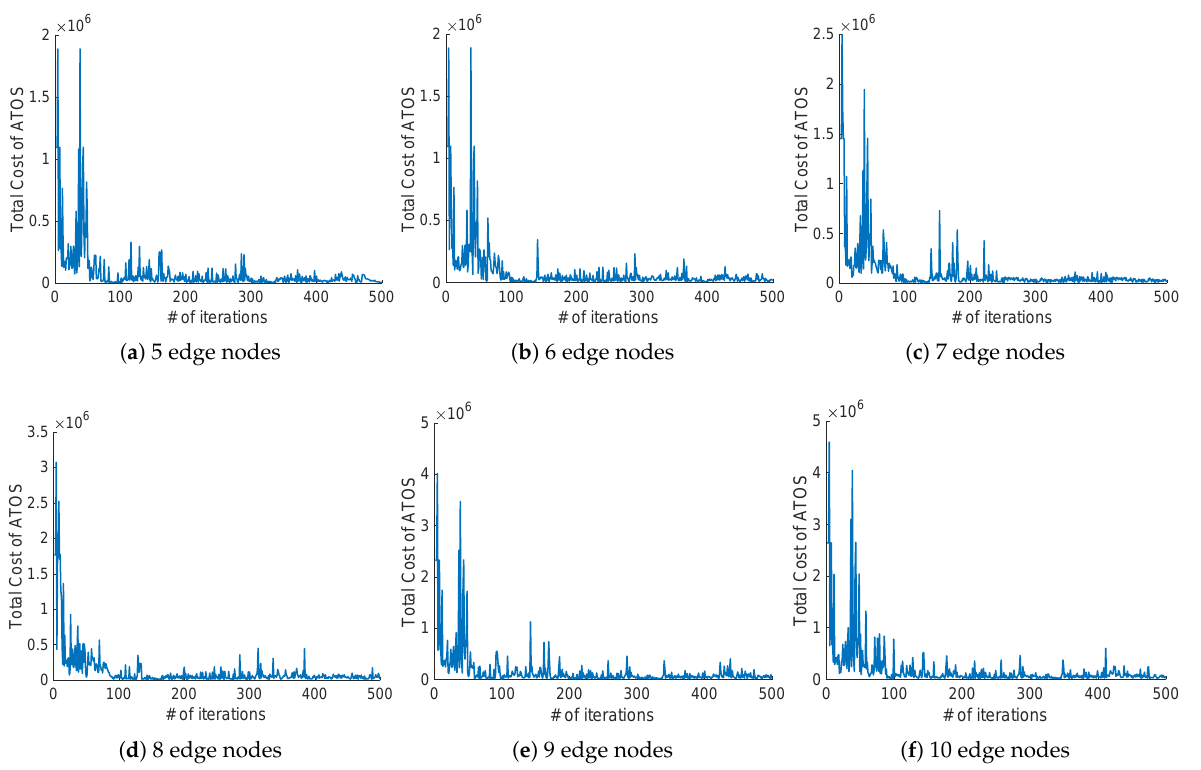
Figure 5. The convergence of total cost under ATOS with the number of edge nodes ranging from 5 to